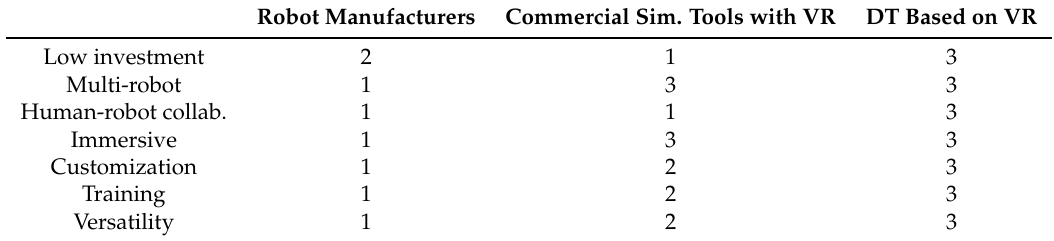
Table 1. Comparative between simulation tools and the proposed approach. Robot Manufacturers Commercial Sim. Tools with VR DT Based on